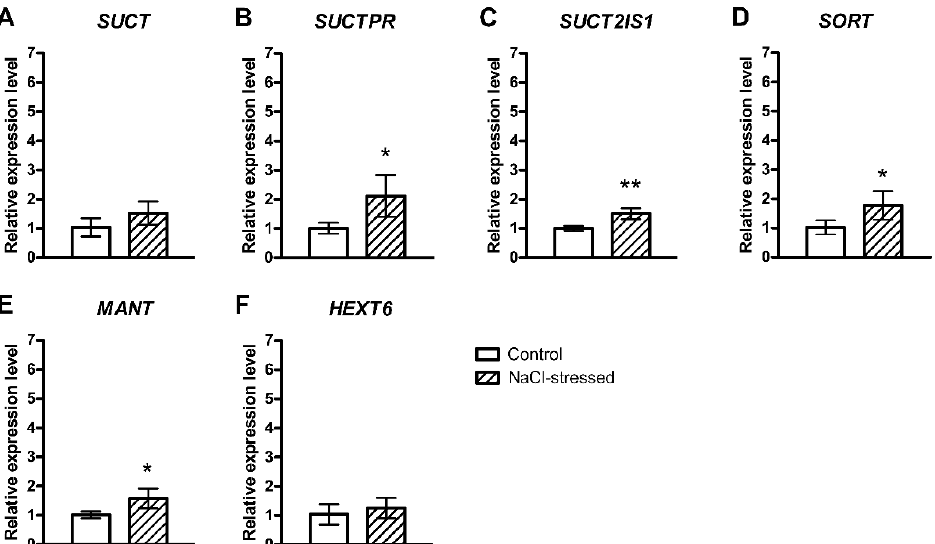
Figure 1. Relative expression of genes encoding carbohydrate transporters in the pulp of F. carica (cv. Dottato) fruits harvested from 100 mM NaCl-stressed plants after 48 days. The values were determined with RT-qPCR. ( A ) Sucrose Transporter ( SUCT ); ( B ) Sucrose Transporter 4-Like ( SUCTPR ); ( C ) Sucrose Transporter 2 Isoform 1 ( SUCT2IS1 ); ( D ) Sorbitol Transporter ( SORT ); ( E ) Probable Mannitol Transporter ( MANT ); ( F ) Hexose Transporter 6-Like ( HEXT6 ). Fold change values are means ± SD of three biological replicates. Asterisks indicate statistically significant differences (* p ≤ 0.05, ** p ≤ 0.01).